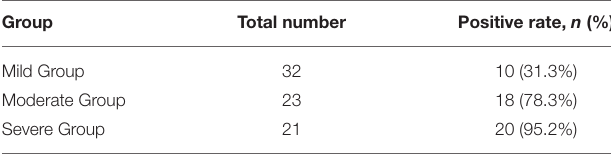
TABLE 2 | Comparison of a high signal positive rate of globus pallidus on MRI T1WI in different groups of children (chi-square test, p < 0.05).